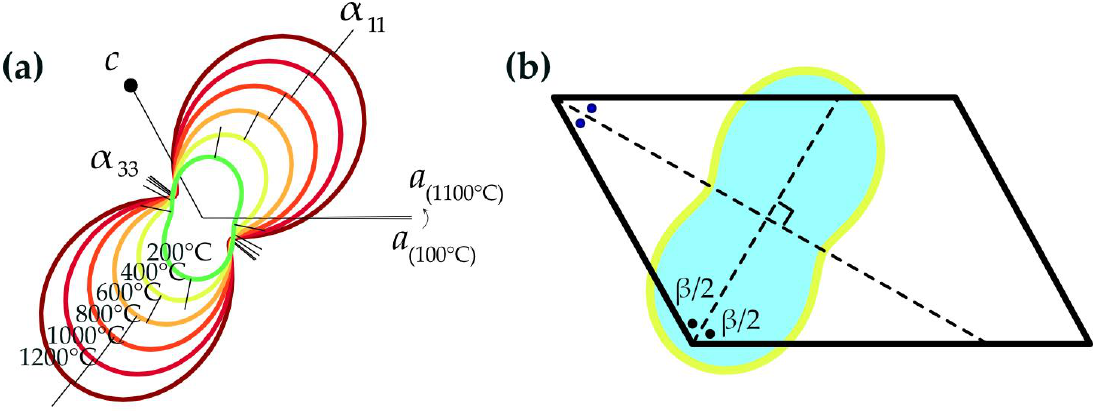
Figure 8. Spherical diagram of the thermal expansion tensors of brannerite ( a ) and the projection on the unit cell ( b ). The β angle decrease is accompanied by the expansion along the α 11 direction, which is a bisector of an obtuse angle.